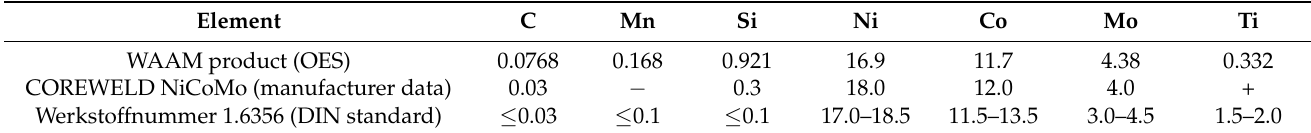
Table 2. Chemical composition of tested 18Ni-12Co-4Mo-Ti maraging steel. Mass